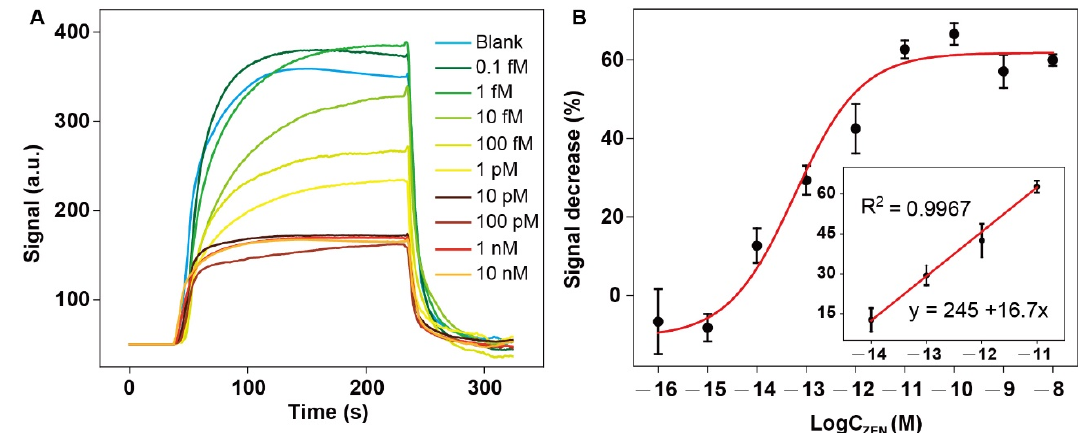
Figure 8. ( A ) The dose–response curves and the calibration curve ( B ) of the NADL-EWOF aptasensor upon the injection of corn extract samples spiked with ZEN at a broad concentration range. The concentrations of ZEN shown in the figures are the final concentrations of ZEN in the 1000-fold diluted corn flour extracts. The actual ZEN concentrations in the undiluted corn flour extracts are 1000-times of the values shown in the figures.